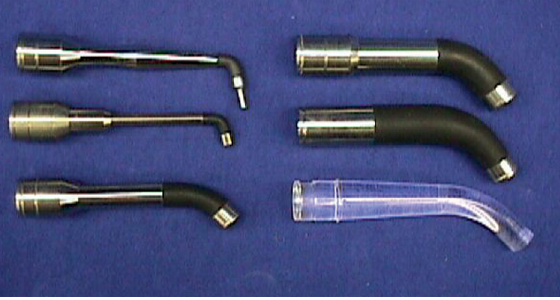
Figure 14. Different styles of removable fiberoptic light guides used in QTH